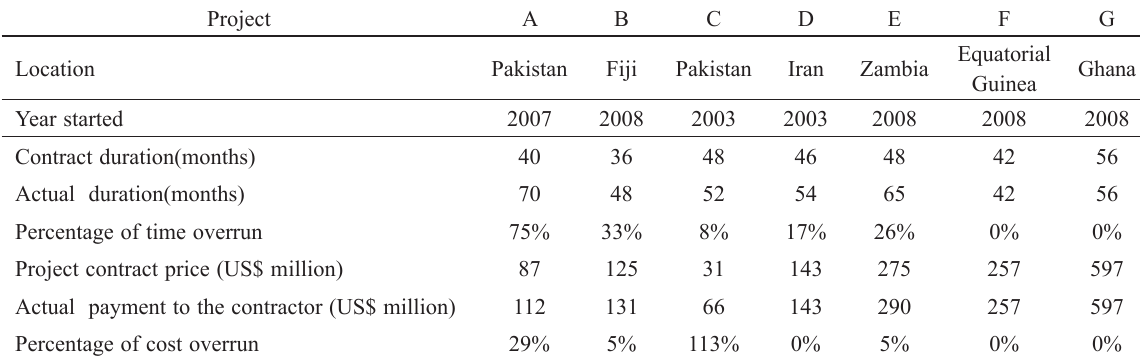
Table 6. International EPC project